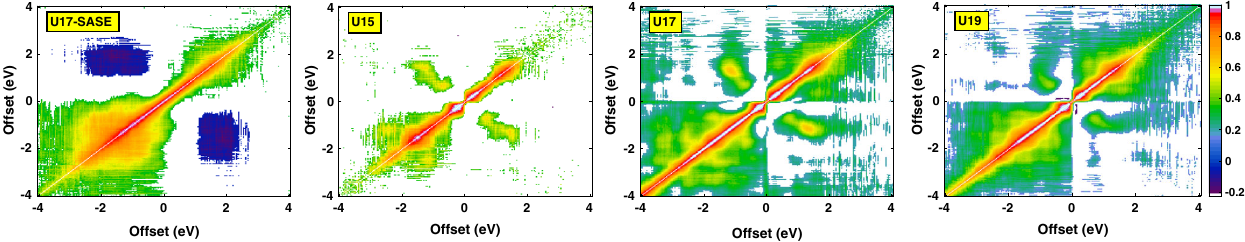
FIG. 13. False color representation of the Pearson correlation coefficients for intensity spectra from the November 2017 shift. The LH strength was 12 μ J in all cases and the individual shots were restricted to those both whose normalized electron beam energies were within (cid:2) 8 × 10 − 5 of the mean (twice as large for the blocked seed U17 and self-seeded U15 cases to produce better statistics) and whose seed intensity I i satisfied 0 . 8 ≤ I i = h I i ≤ 1 . 25 . The latter filtering was done to minimize any PSF-induced correlations. To improve the visual contrast, only those correlation coefficients whose statistical significance exceeds 3 . 3 σ are shown in a nonwhite color. Negative correlation coefficients are clipped to a − 0 . 2